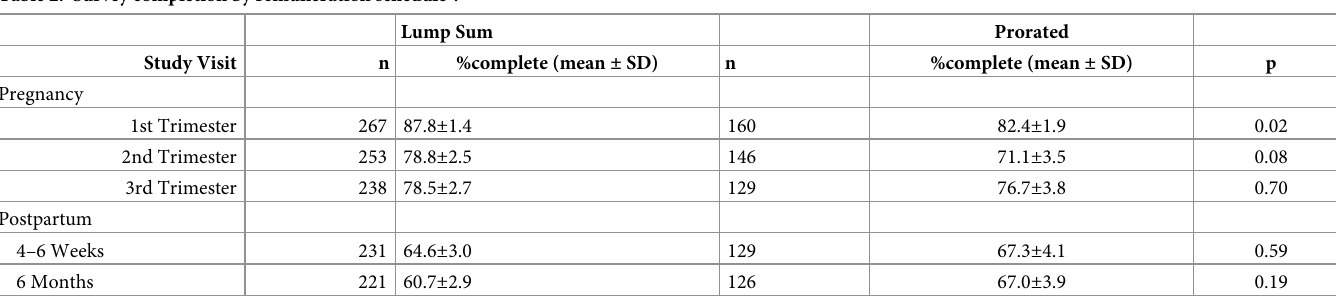
Table 2. Survey completion by remuneration schedule a .